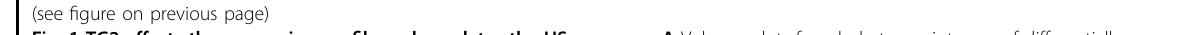
Fig. 1 TG2 affects the expression pro fi le and regulates the HS response. A Volcano plots for whole transcriptomes of differentially expressed genes between KO and WT MEFs. B Venn diagrams illustrating the overlap of the differentially expressed genes (down- or upregulated genes, FC ≤ − 1,5 or ≥ 1,5, p val_adj ≤ 0.05) between KO and WT MEFs, under heat shock. C Gene set enrichment analysis barcode plot of transcriptomic changes of “ Cellular response to heat stress ” and “ regulation of HSF1 mediated heat shock ” (from Reactome database) in KO MEFs compared with WT MEFs. Red, blue, and pink shaded rectangles mark upregulated, downregulated, and genes that are unchanged, respectively. D Transient knockdown of the putative TG2 paralogous was performed with three independent morpholinos against zTg2a, zTg2b, and zTg2l; a standard control morpholino was also used. Bright- fi eld images of representative morphants are reported. ( n = 50). Bars: 1 mm. E Double transgenic Tg(-1.5hsp70l:GAL4 ( + / − ) ; UAS: Kaede ( + / − ) ) were injected at one-cell stage either with Tg2bMO or CtrlMO, heat-shock inductions were performed at 24 hpf by incubation of larvae for 1 h at 37 °C, whereas images were acquired between 29 and 30 hpf. Heat-shock protein activation was followed by an increase in the fl uorescence. Bright- fi eld and epi fl uorescent images are reported. The images are representative of different experiments. GFP epi fl uorescence quanti fi cation is reported in the graph on the right. Dots represent treated embryos ( n of embryos >40). Thapsigargin was used as a positive control. ( n = 3; means±SEM; * p < 0.05; *** p < 0.001). Bars: 1